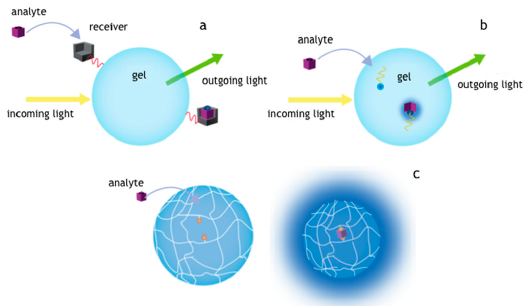
Figure 1. Schemes for proteins and oligonucleotides detection implemented in microgels and hydrogel microparticles with optical fluorescence read-out. In ( a ) is depicted the recognition of the target by a ligand placed on the surface of the gel, in ( b ) the capture molecules are copolymerized inside the hydrogel network. In ( c ) is reported a scheme of recognition of two distinct regions on the target and a transduction mechanism of the capture based on volume phase changes or Förster resonance energy transfer (FRET)